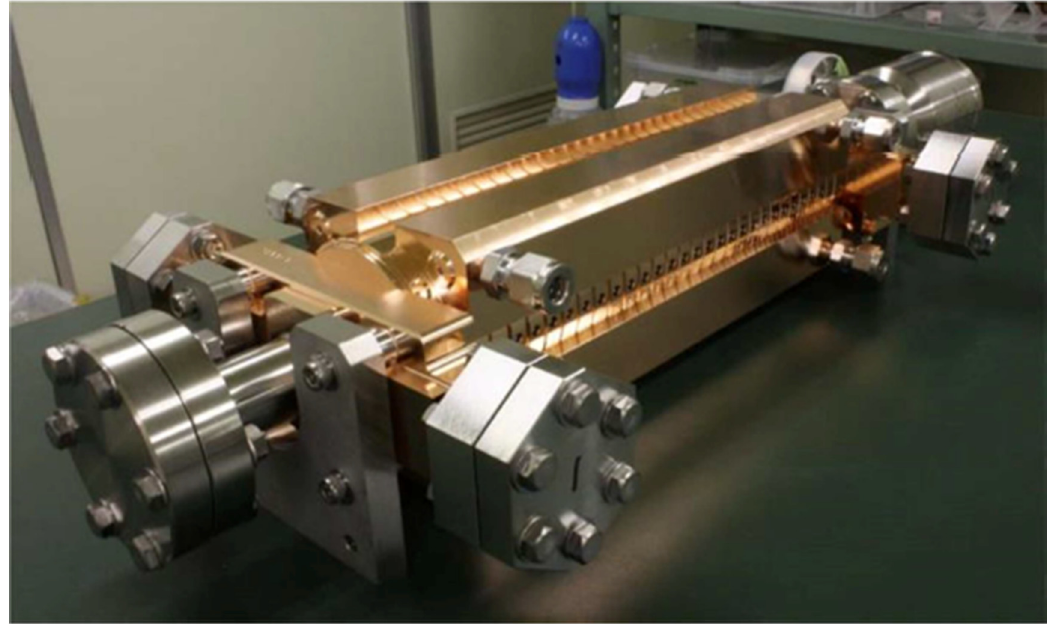
Figure 3. The CLIC T24 X-band accelerating structure, operated up to 120 MV/m, (CLIC CDR Vol1, CERN, 2012).